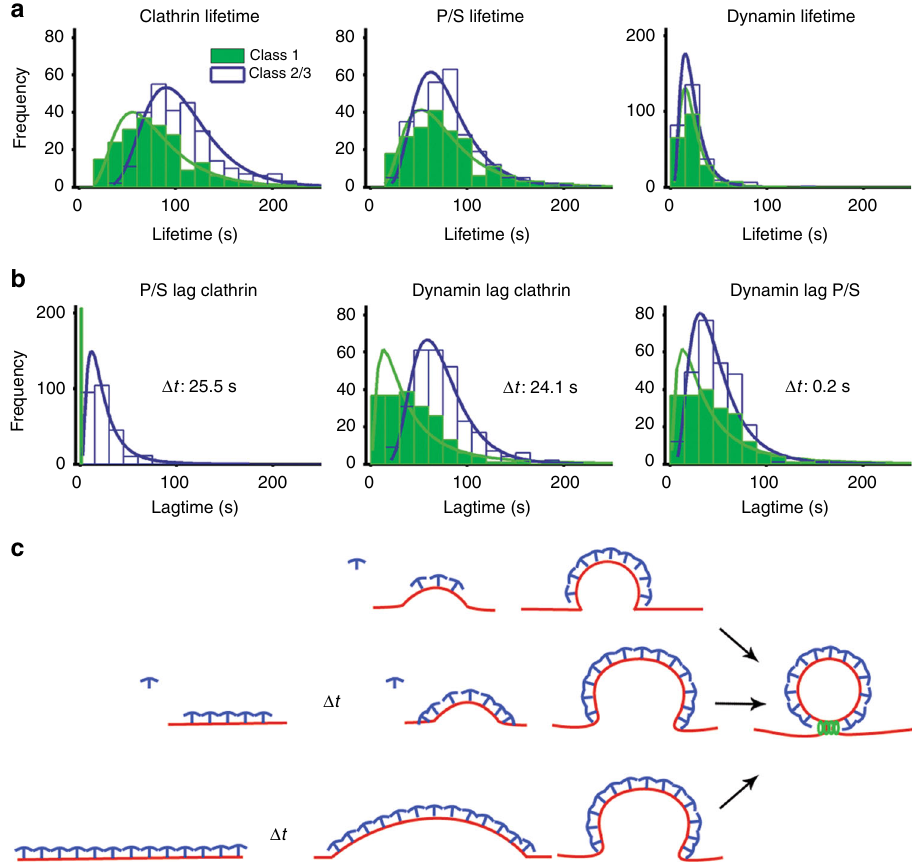
Fig. 4 Lifetime analysis of clathrin events. a Lifetime distribution for clathrin, P/S, and dynamin; Class 1, green bars and line, Class 2/3 open with blue line. b Lag time for P/S and dynamin relative to the start of the clathrin events, and lag time for the start of dynamin relative to the start of P/S. c Relationship between clathrin assembly and membrane bending during CME